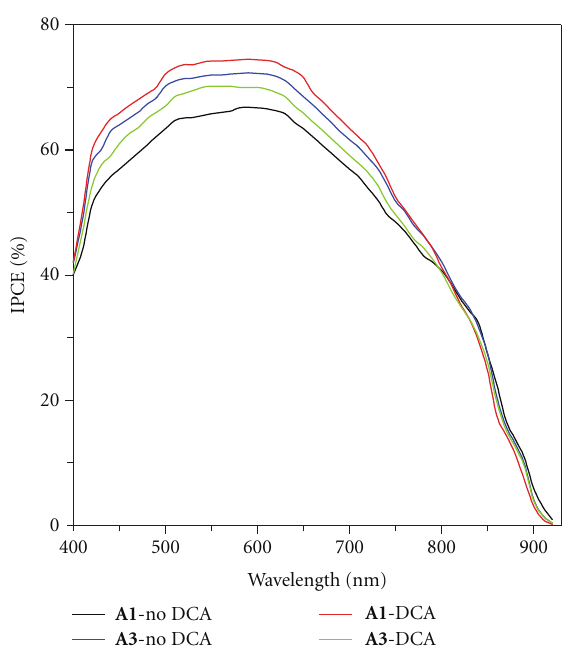
Figure 5: Photocurrent action spectra obtained with complexes A1 and A3 with and without DCA addition during the sensitization process. Incident photon-to-current conversion e ffi ciency is plotted as a function of wavelength. A sandwich type sealed cell configura- tion was used to measure this spectrum. The electrolyte composi- tion was 0.6M DMPII, 0.05M I 2 , and 0.1MLiI in